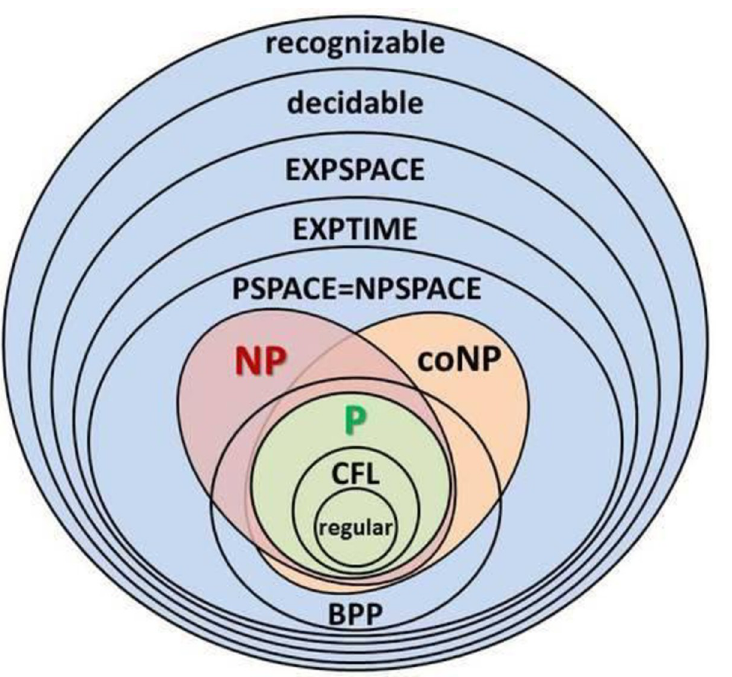
Fig 4. Diagram representation for the many categories of computational